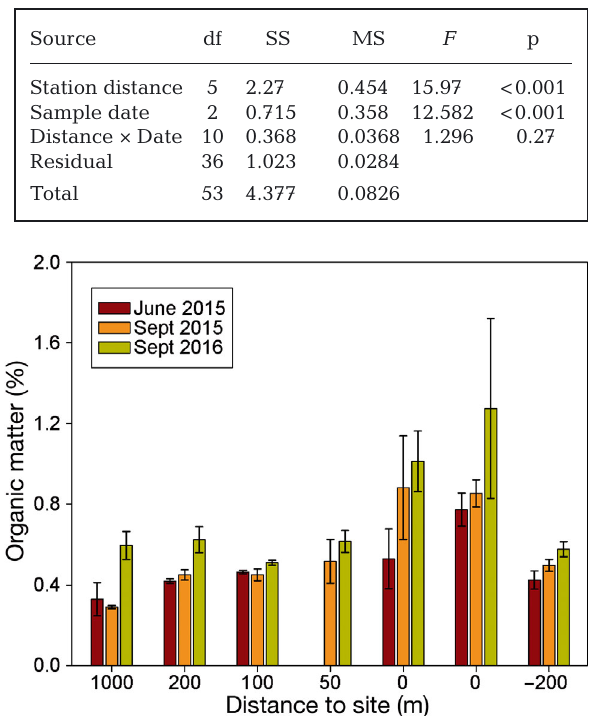
Fig. 8. Jordan Bay bottom sediment organic matter per- centage from all samplings. The sample stations are in the direction of mean flow and represent distance from the site with the 0 m stations representing the opposite sides of the cage site. See Fig. 1 for more detail on sampling layout. Error bars: 1 SD